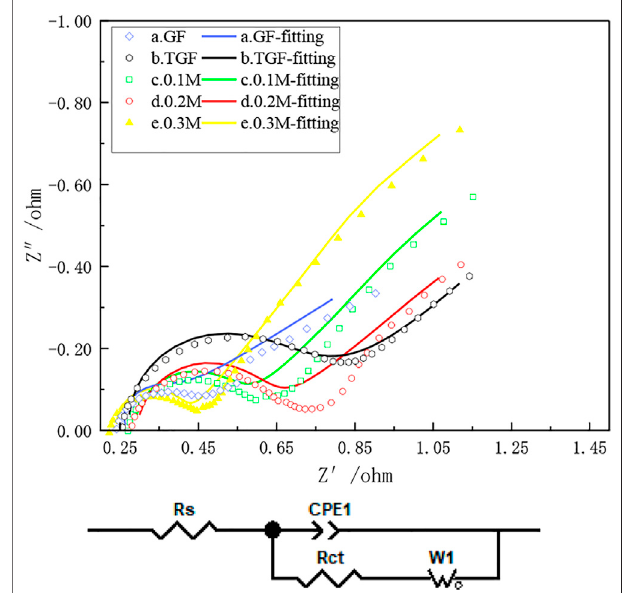
FIGURE 7 | Samples (a), GF; (b), TGF; (c), heat-treated graphite felt after immersion in 0.1 MM InCl 3 solution; (d), heat-treated graphite felt after immersion in 0.2 MM InCl 3 solution; (e), heat-treated graphite felt after immersion in 0.3 MM InCl 3 solution, electrochemical impedance Diagram and Equivalent Circuit